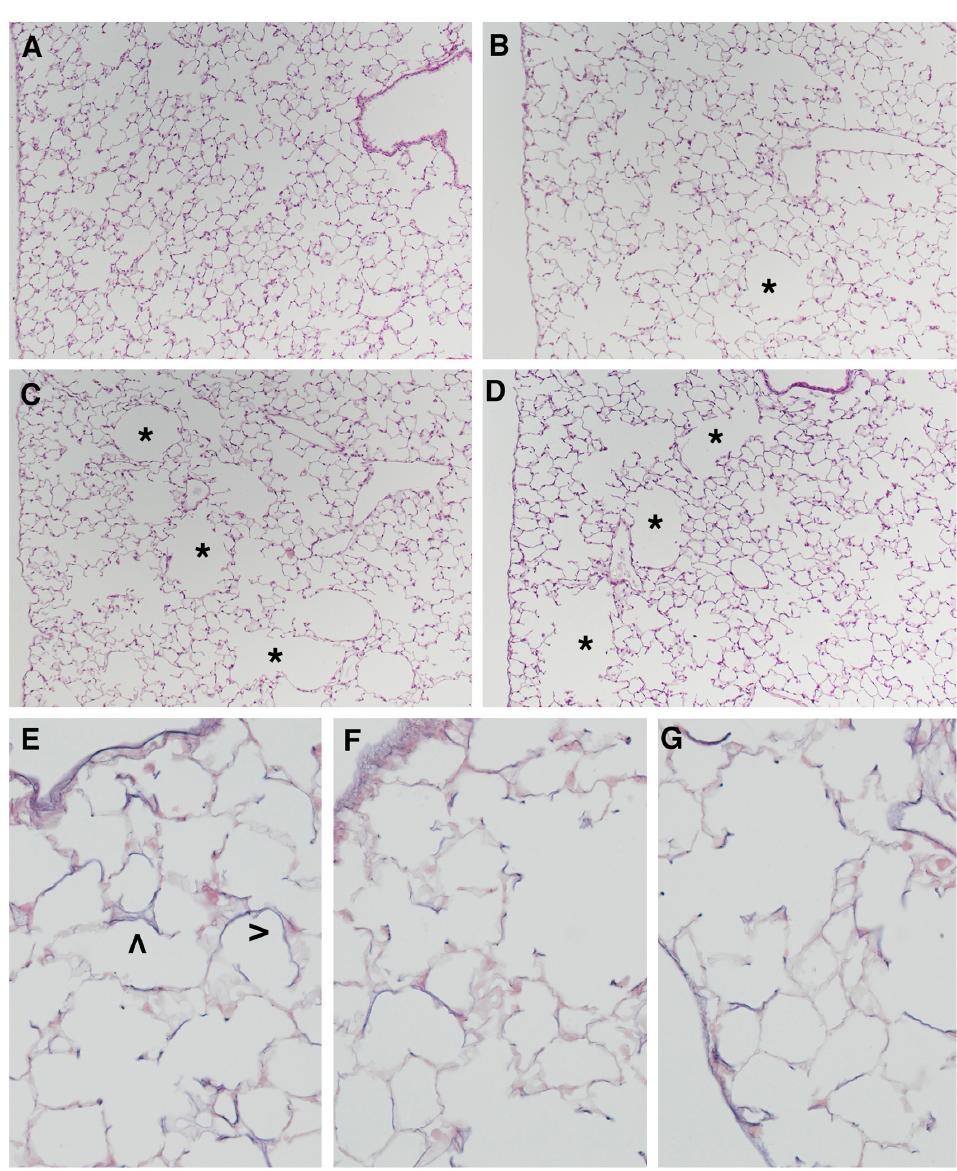
Figure 1. Representative histologic sections from lung parenchyma at different times from the start of the study: ( A ) Lung from an air-exposed mouse showing normal architecture; ( B ) lung from a mouse after 4 months of smoke exposure showing patchy areas of lung emphysema (*); ( C ) lung from a mouse after 10 months of smoke exposure, emphysematous changes are more severe (*) and the confluence of several air spaces due to the loss of the septa is evident; ( D ) lung from a mouse left to rest in room air after 4 months of CS exposure. Note the progression of emphysematous changes in respect to those present in (B); ( E ) elastin (>) distribution in lung from air-exposed mouse, elastin is uniformly distributed normal lung parenchyma; ( F ) elastin distribution in lung from mouse after 10 months of smoke exposure, note the presence of an uneven distribution of the elastin. In some septa elastin fibers appear fragmented or barely visible; ( G ) elastin distribution in lung from mouse left to rest in room air after 4 months of CS exposure. In the periphery of the emphysematous areas, the elastic fibers appear evanescent and fragmented. ( A – D ) hematoxylin/eosin stain, × 40 and ( E – G ) Miller’s stain for elastin, ×